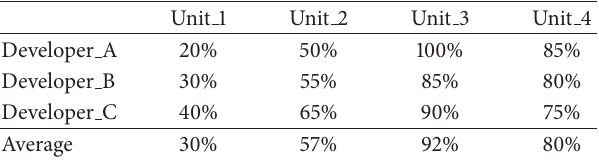
Table 1: Data gathered for an example